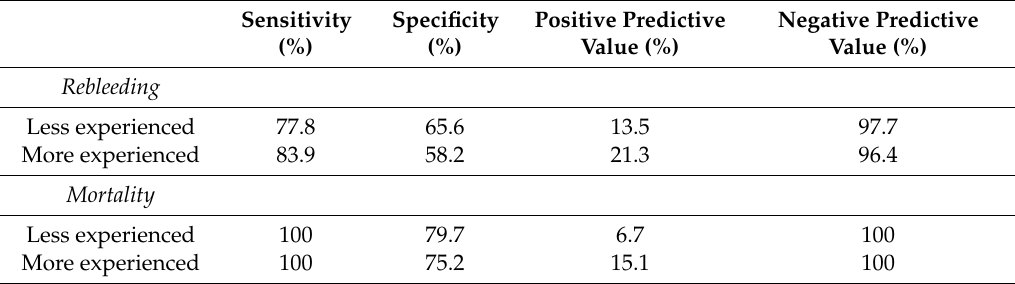
Table 6. Sensitivity, specificity, positive and negative predictive values for predicting rebleeding and mortality according to the experience of the